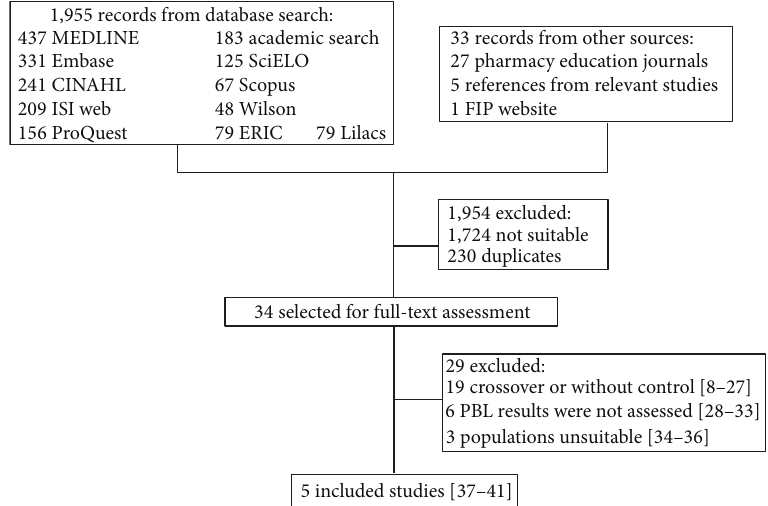
Figure 1: The search, selection, and inclusion process used in the